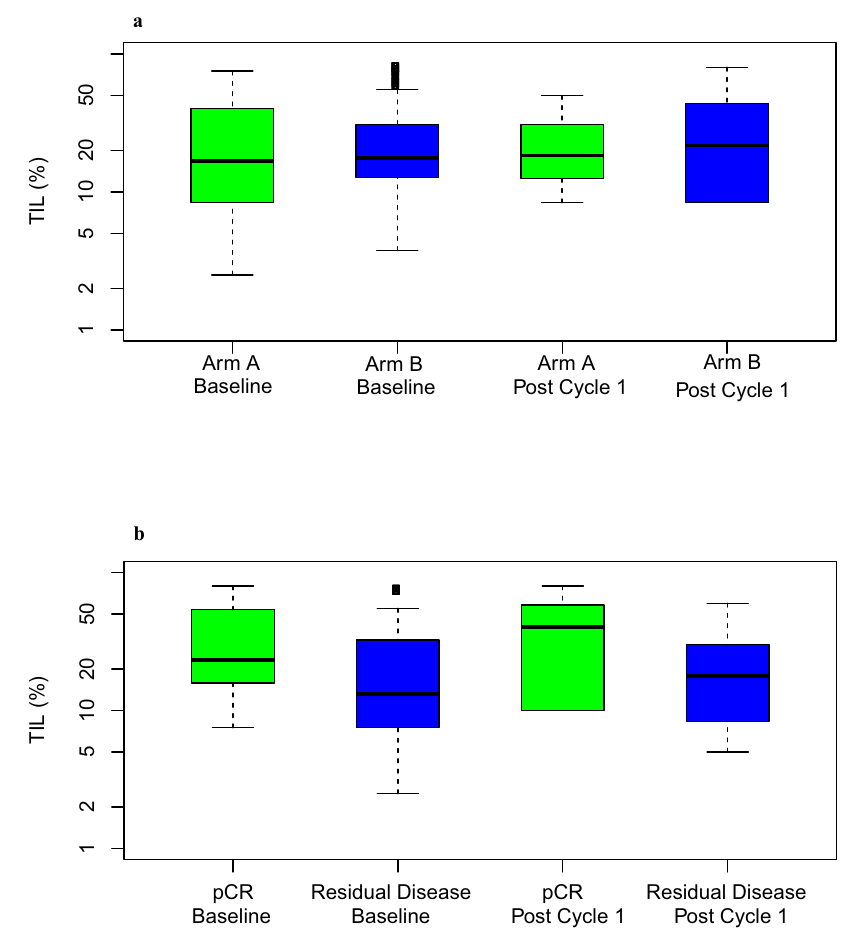
Fig. 4 TIL analyses. Boxplots of logarithm transformed TIL (%) by pCR status ( a ) and treatment arm ( b ), where the box stands for the interquartile range, the bar inside a box represents the median, and the whiskers represent the whiskers represent 5 th and 95 th